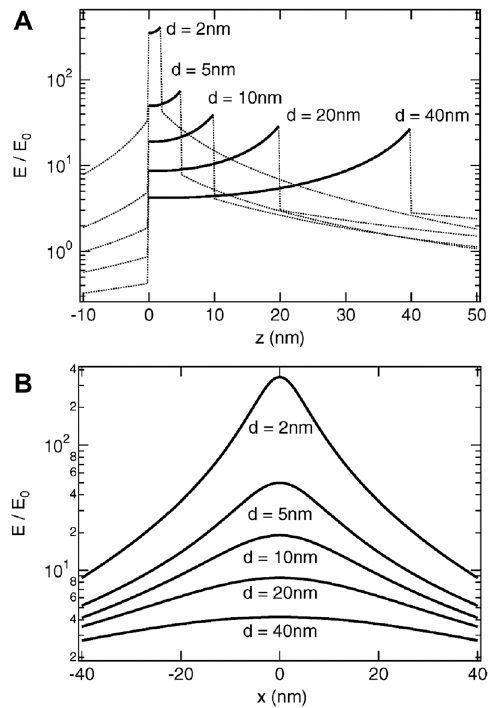
Figure3: (A)Simulatedvariationofthefieldenhancementfordifferent distancesrangingfrom2to40nmbetweenAutipandAusubstrate.(B) Simulated lateral cross-sections of the enhanced optical fi eld near the Au surface for different tip-substrate distances. Reprinted with permission from [70]. Copyright (2008) American Chemical